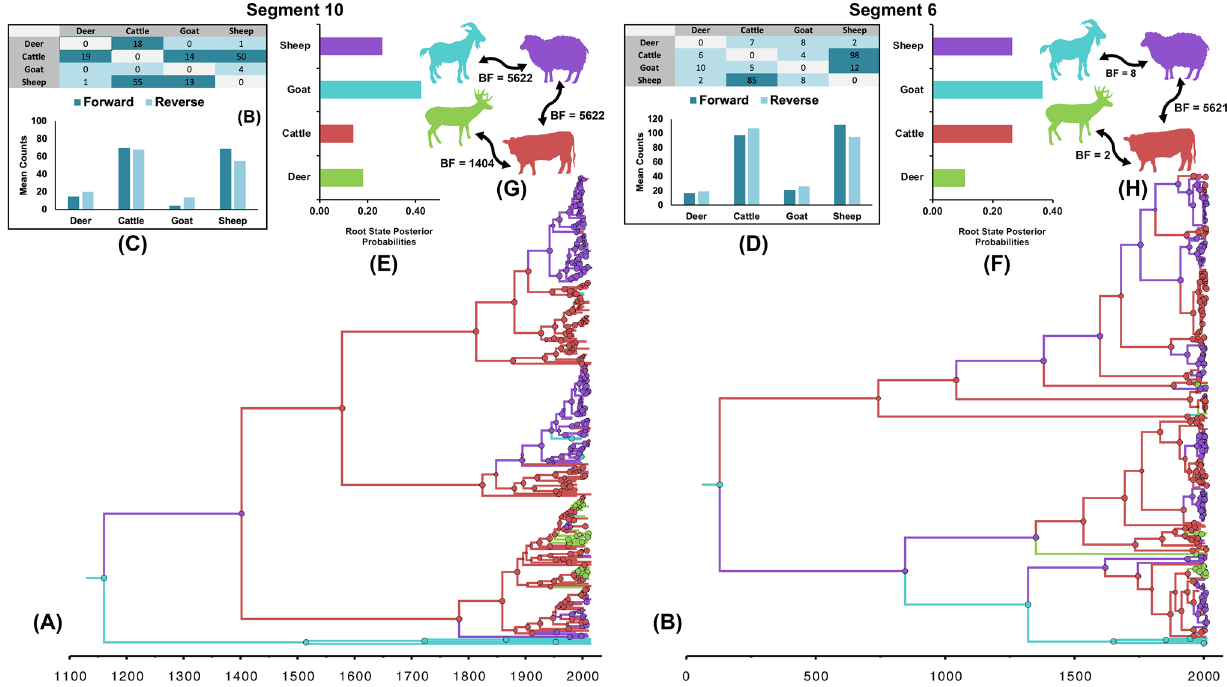
Figure 5. Ancestral host-species discrete trait reconstruction for segments 10 and 6 sequences of Bluetongue virus between 1958 and 2016. ( A , B ) Maximum clade credibility (MCC) tree. Branches’ colours represent the most probable host state of their descendent nodes and color-coding corresponds to ( E ) and ( F ). ( C , D ) Posterior mean counts of the Markov jumps (MJ) over the phylogeny of bluetongue virus. Matrix on the top summarize relative forward and reverse transitions between pairs of discrete traits (i.e., hosts). ( E , F ) Root state posterior probabilities (RSPP) inferred from the symmetric host discrete trait model. ( H , I ) Significant transmission routes between host species inferred BSSVS approach. BF values are on the top of the arrows. Blue indicates goat, purple indicate sheep, red indicate cattle, and green indicate deer. Cells shaded dark blue indicate MJs greater than 10. Charts on the bottom summarize total relative forward and reverse transitions for each host. ( A , C , E , G ) Indicate segment 10. ( B , D , F , H ) Indicate segment